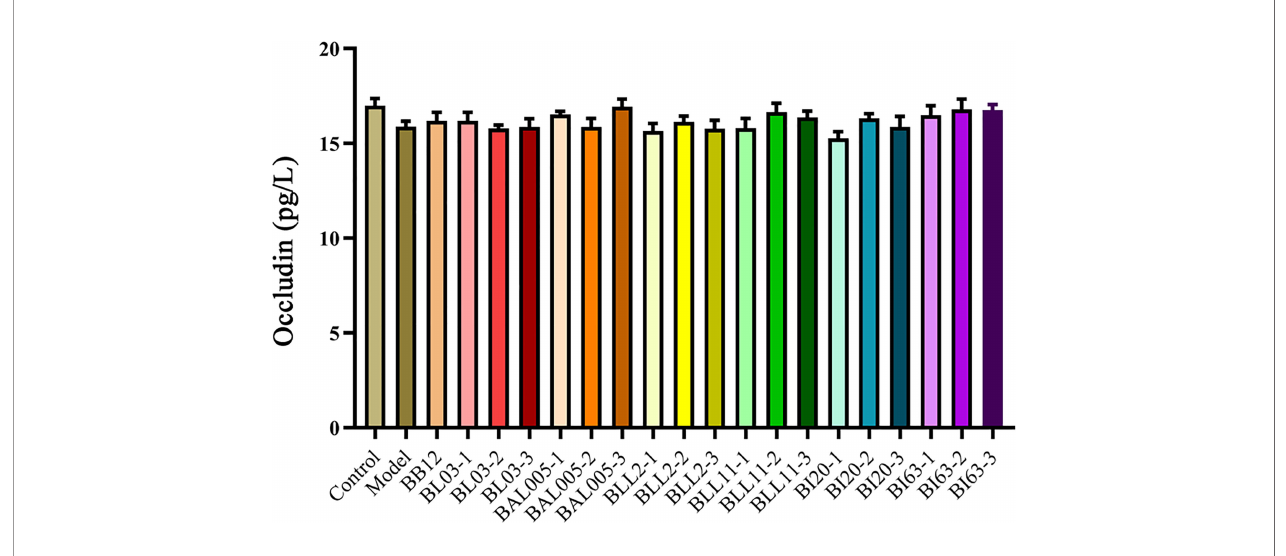
FIGURE 5 | The occludin levels in serum of mice treated with different embedding methods.